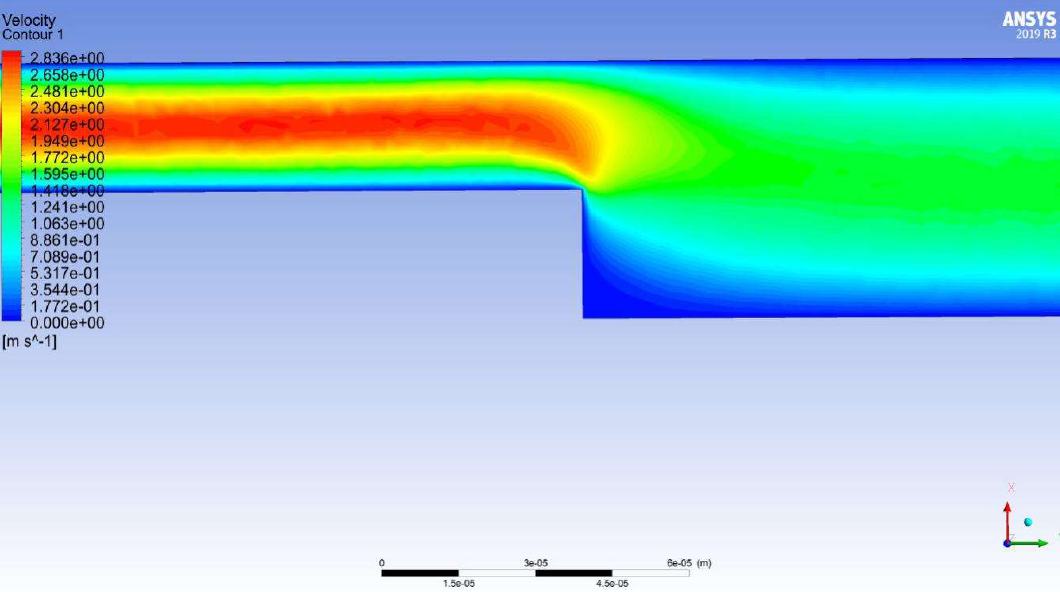
Figure 11. Velocity vector distribution in the Reynolds Stress turbulence model.